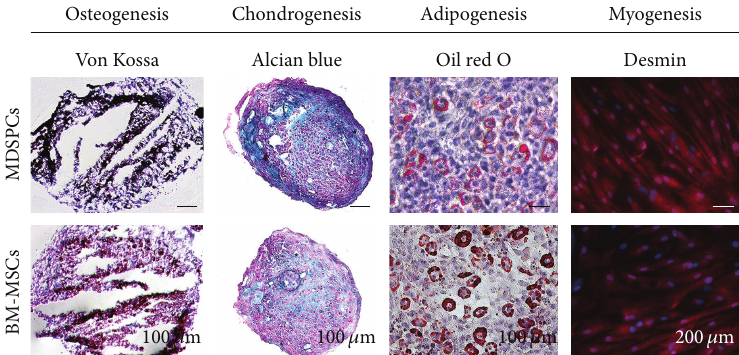
Figure 4: Multilineage differentiation of MDSPCs and BM-MSCs. Cells cultured in osteogenic differentiation medium formed bone nodules as determined by von Kossa staining. Cells cultured in chondrogenic differentiation medium had lacunae surrounded by the Alcian blue- stainedmatrix.Cellsculturedinadipogenicmediumformedlipiddroplets,whichwerepositiveforoilredOstaining.BM-MSCsandMDSPCs differentiated into myogenic lineage and became multinucleated, elongated, and highly positive for desmin ( >